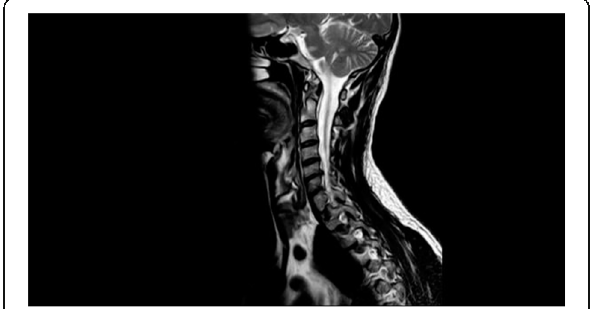
Fig. 1 (abstract P33). See text for